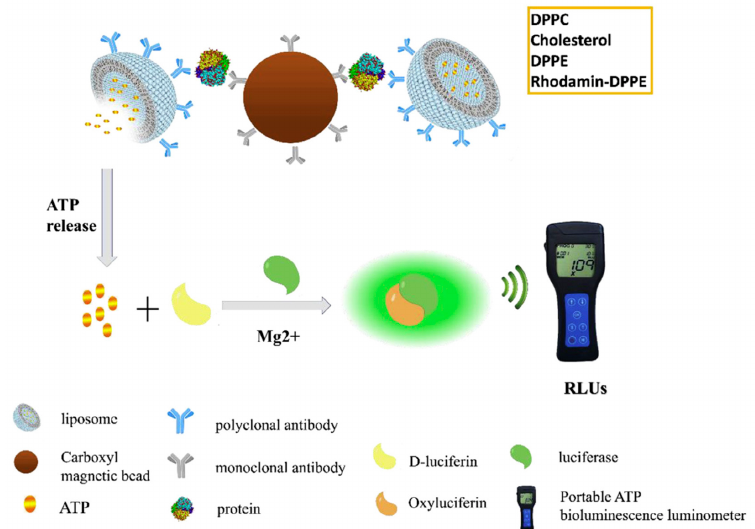
Figure 13. Schematic representation of the liposome-based bioluminescent magnetic (LBM) assay based on the selective capture of a given protein using magnetic beads and ATP-containing liposomes properly functionalized with the specific antibody for the protein of interest. Figure reprinted from [68], Copyright (2018), with permission from Elsevier. The output was reported as RLUs (relative light units), where 1 RLU corresponded to 1 fmol of ATP. RLUs showed a linear correlation with AFP concentration between 0.05 and 1000 ng/mL, with a limit of detection of 0.016 ng/mL. The assay exhibited high specificity for AFP, with no cross- reactivity with five other proteins tested at 25 ng/mL. A value higher than 300 RLUs indicated an AFP concentration greater than 25 ng/mL, suggestive of the possible occurrence of hepatocellular carcinoma and the need for further clinical examination. The LBM assay showed high reproducibility; accuracy; low-cost potential; and, in principle, it can be extended to a variety of proteins by replacing the antibody pairs according to the desired targets. Such innovative approach that allows for the quantitative detection of biomarkers with a portable luminometer could likely find a wide applicability in the field of the analyses of clinical samples. In summary, although to date the attention on magnetoliposomes has been mainly focused on imaging studies or drug delivery applications, one may foresee an important role for these systems in the design of innovative bioassays. They own key features in terms of separation efficiency and signal amplification for their use as tools in bioanalysis, namely, (i) they show a large flexibility in composition, size, and MNP surface chemistry; (ii) they display a good overall stability during storage and magnetic action; and (iii) they provide an efficient bioassay performance with short times and relatively low cost [69]. 7. Liposomes for the Detection of Extracellular Vesicles Characterization of small extracellular vesicles (sEVs) or exosomes, circulating in body fluids, holds a great potential in the field of non-invasive diagnosis of diseases and in the evaluation of therapeutic treatments. They may be considered a novel class of biomarkers and are under intense investigation for the determination of their inner content as well as their membrane proteins for the